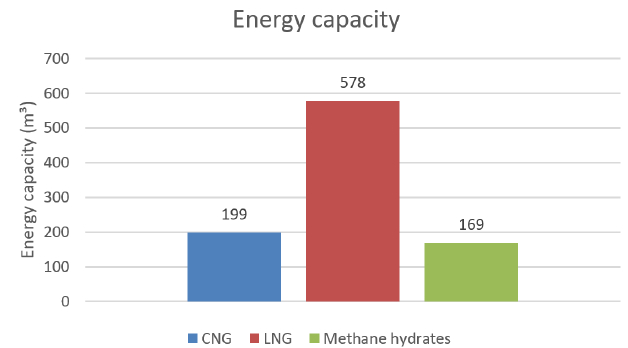
Figure 2. Energy capacity for different